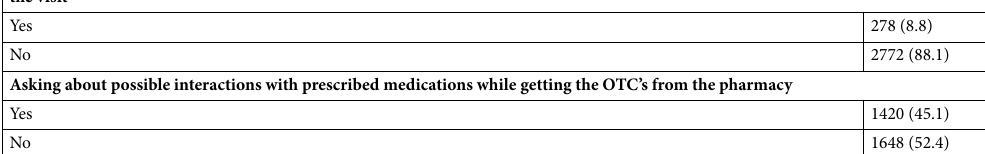
Table 4. Outpatients’ medication-related practices. a Sometimes the cumulative percentages may not reach 100% due to missing values. When missing values are less than 10%, they were not reported explicitly.